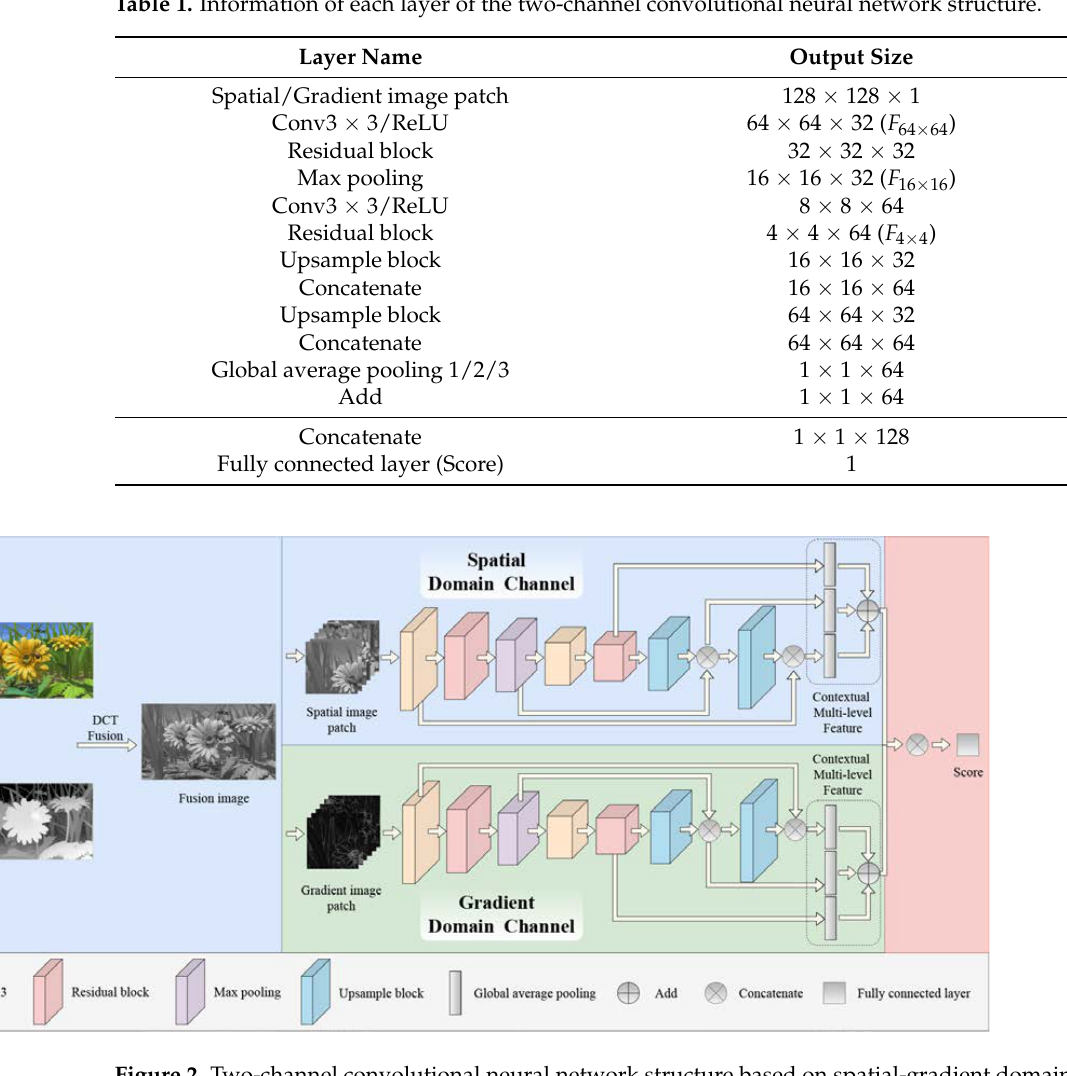
Table 1. Information of each layer of the two-channel convolutional neural network structure.